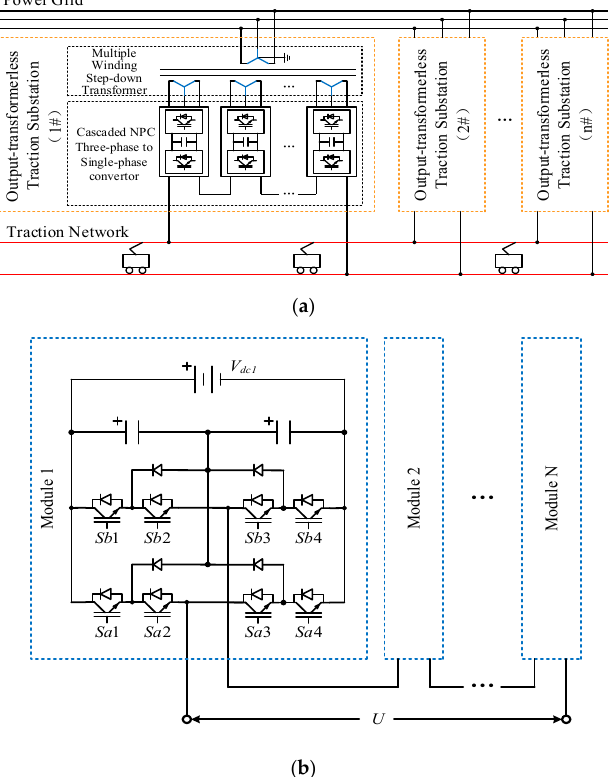
Figure 2. ATPSS-II. ( a ) Configuration of ATPSS-II. ( b ) Single-phase NPC cascaded inverter.